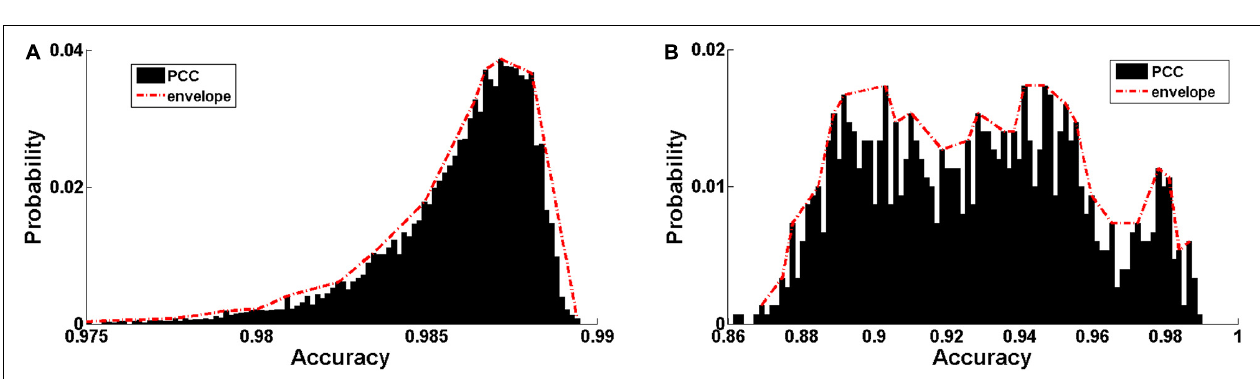
FIGURE 4 | Visualization of learned filters in the DCAE model. (A) Examples of the learned filters in each layer. (B) The power-spectrum patterns of learned filters. The x -axis represents the index of filters, the y -axis represents the frequency ranging from 0 to 8000 Hz.